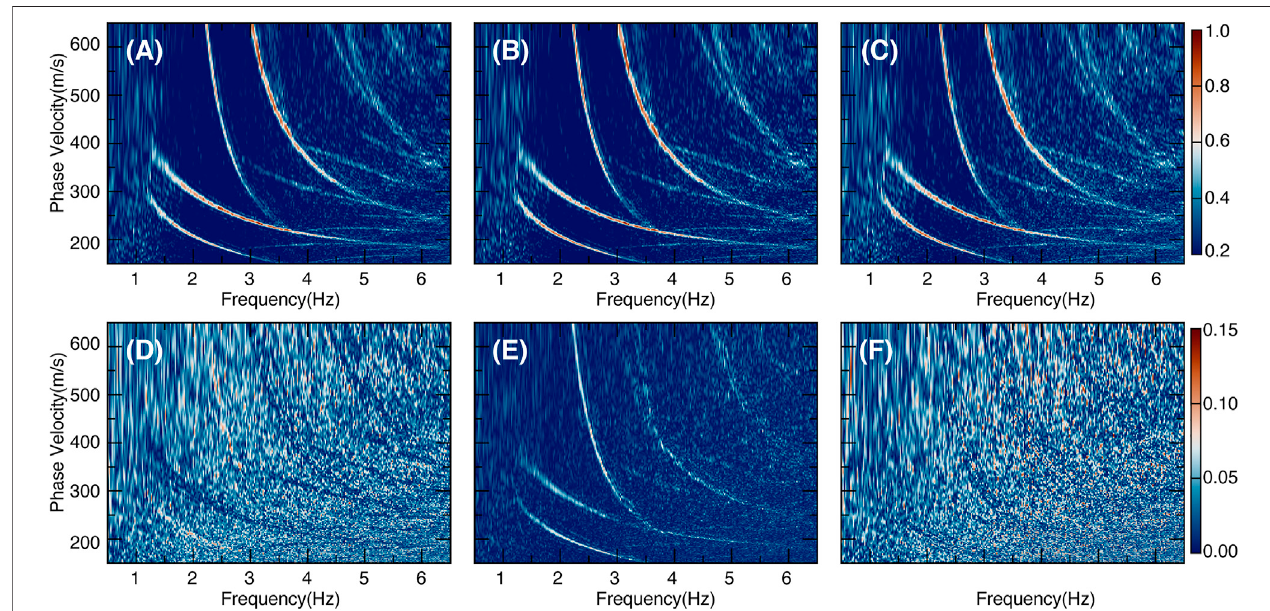
FIGURE 6 | The 4C SVS as calculated from different weights (A, B) and the same weight (C) . The absolute differences between each SVS pair (A – C) are shown in (D – F) .